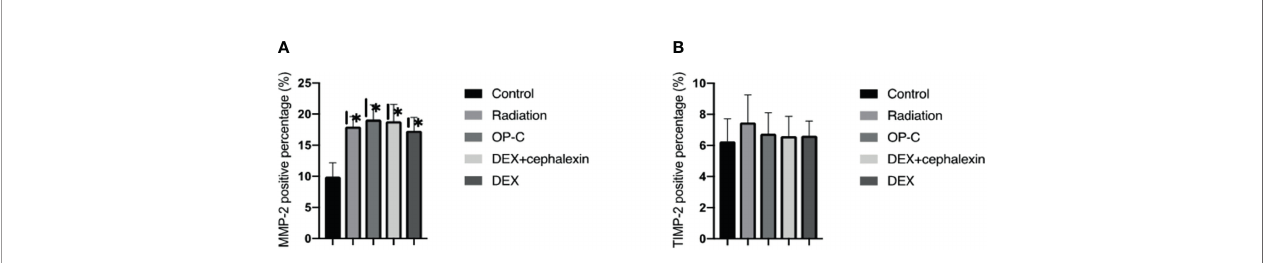
FIGURE 6 | Effects of OP-C on the expression of matrix metalloproteinases-2 (MMP-2) (A) and tissue inhibitors of metalloproteases-2 (TIMP-2) in the lungs (B) . Expressions of MMP-2 and TIMP-2 in the lungs were measured in mice from the blank control, radiation-only, OP-C, DEX, and DEX + cephalexin groups. The presented data are expressed as the mean ± SEM. *p < 0.05, compared with the control group. # p < 0.05, compared with the radiation-only group.